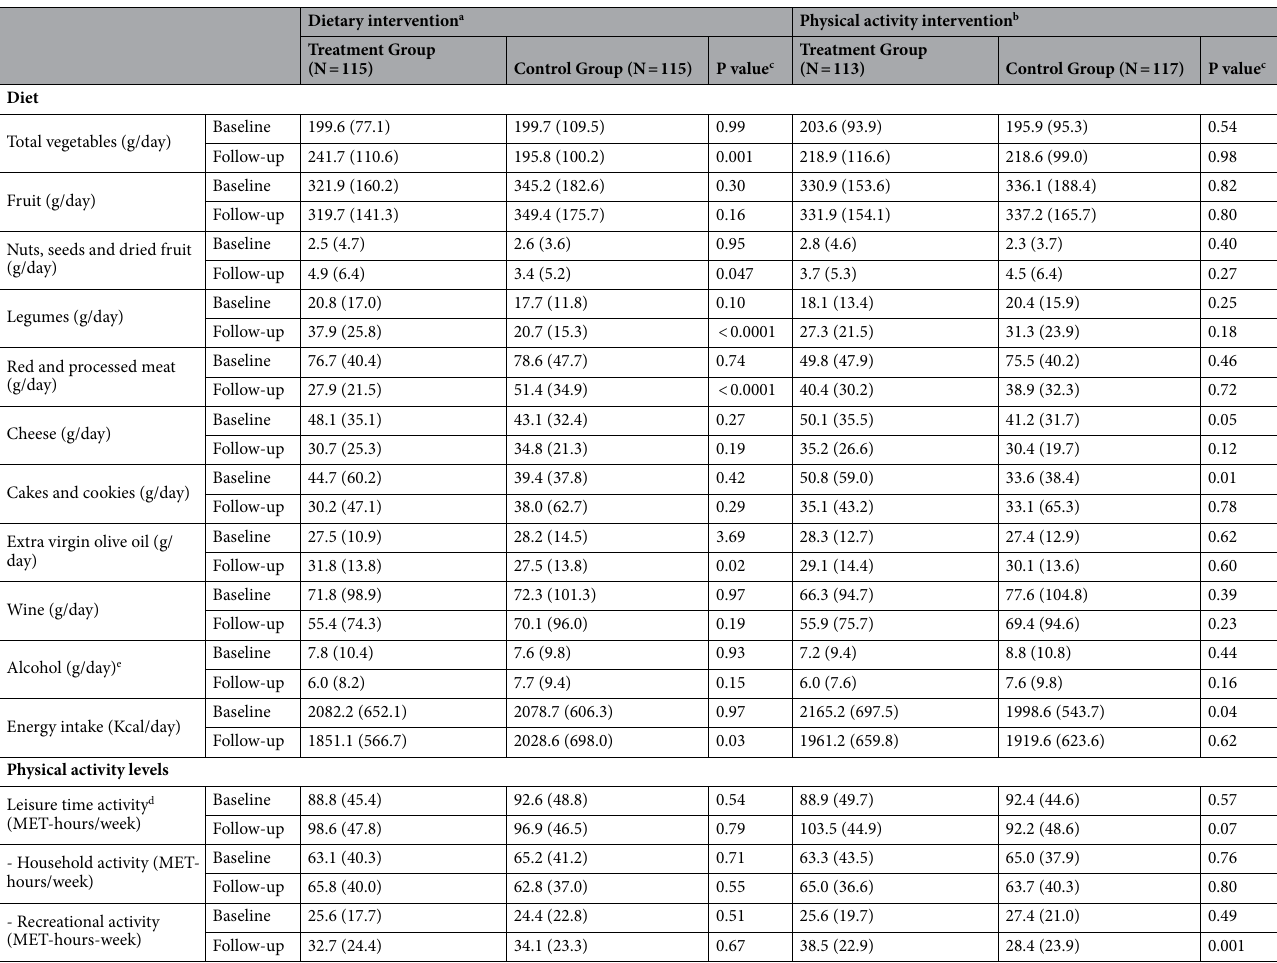
Table 3. Consumption of selected food, alcohol intake, kilocalories and leisure time physical activity level at baseline and at the end of the intervention by treatments. Mean values and standard deviations are reported. The DAMA (Diet, Exercise and Mammography) trial. a Arms #1 + #3 versus arms #2 + #4. b Arms #2 + #3 versus arms #1 + #4. c P values were calculated from GLM comparing each intervention group with the its control group. d Including household and recreational activities. e Alcohol intake from all alcoholic